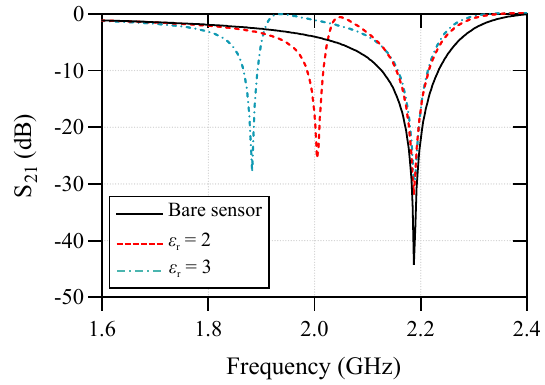
Figure 6. Simulated S 21 for the bare sensor and when one of the sensing elements is loaded with a test sample of ε r = 2 and ε r =